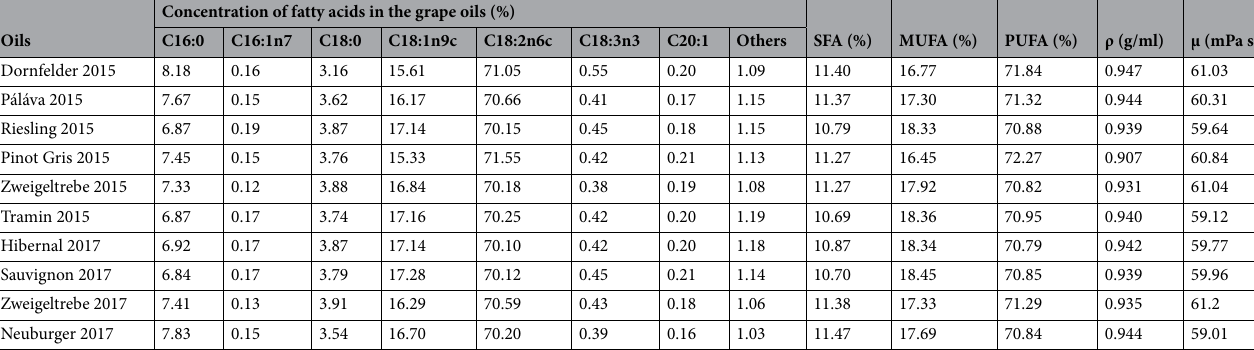
Table 1. The relative concentration of fatty acids in grape oils. The concentration of saturated, monosaturated, and polyunsaturated are presented along with the physical properties (measured at 20 °C), which are the apparent viscosity (µ) and the mass density